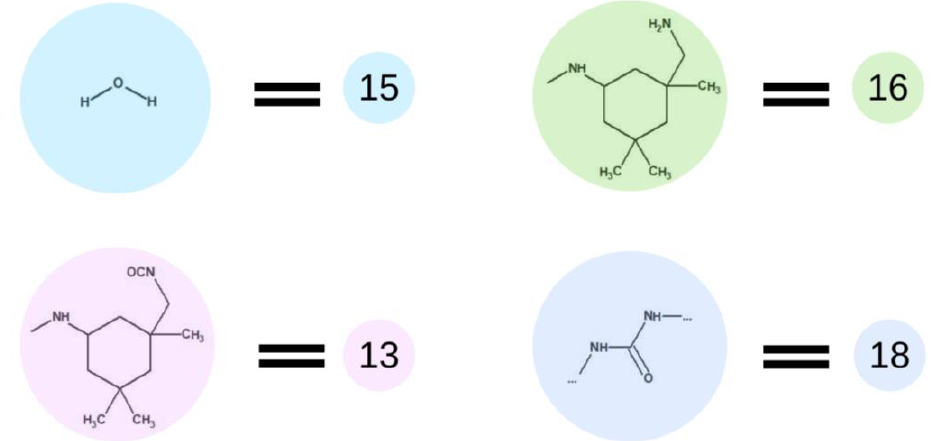
Figure 7. Schematic representation of the base unit participating in the curing process.